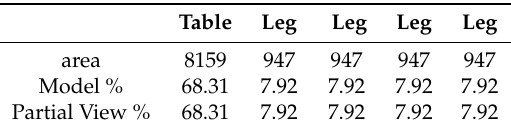
Table 3. Example of the weights for the comparison of the dining table graph, based on the area of each geometrical